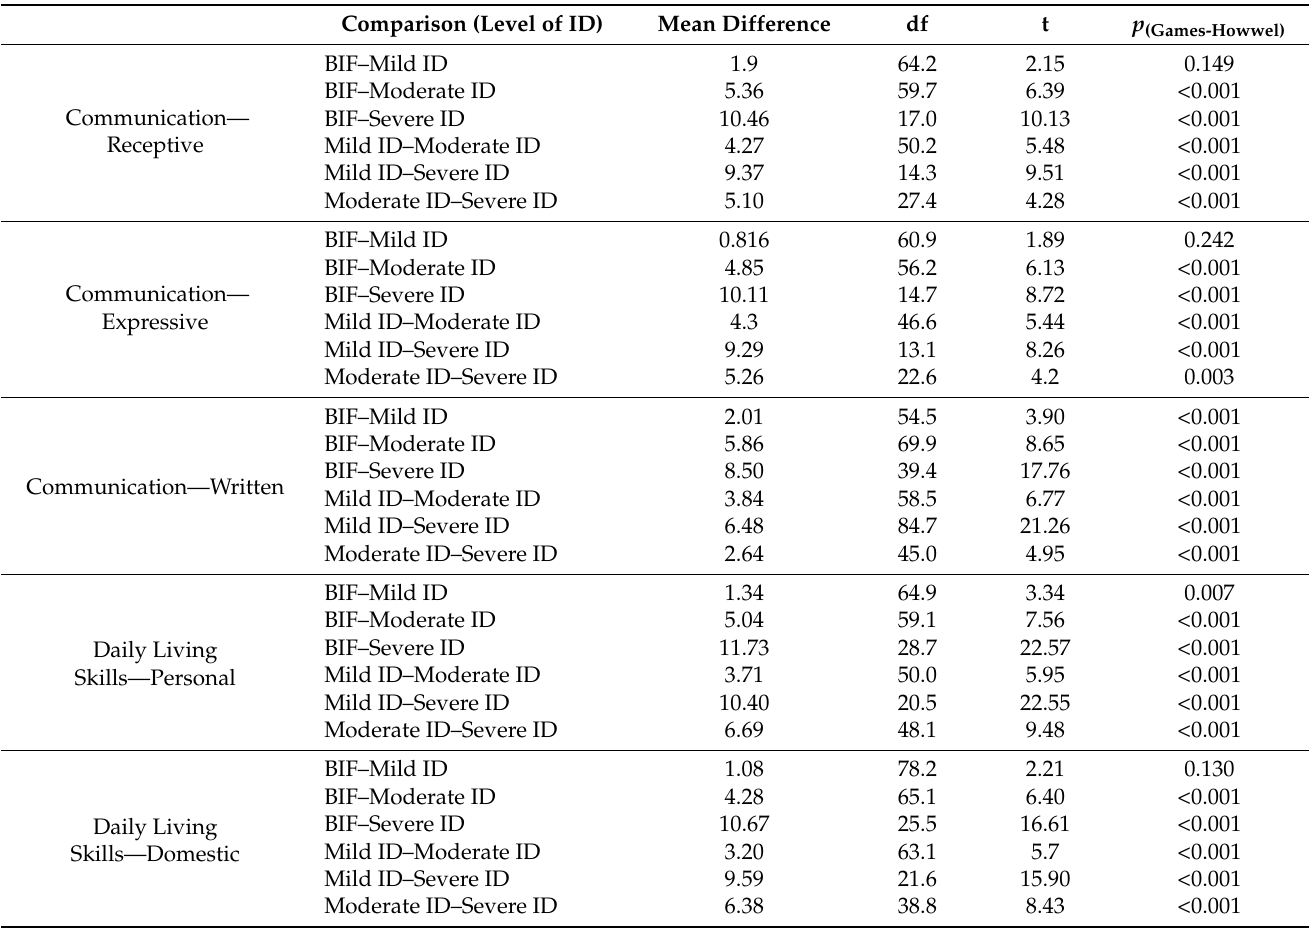
Table A3. Post hoc comparisons of AB subdomain in different levels of